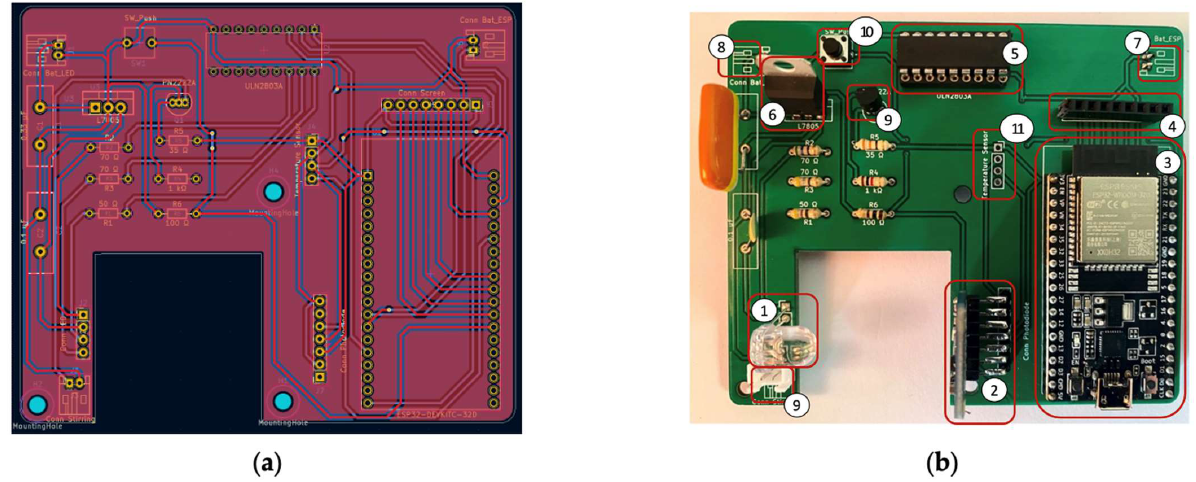
Figure 6. ( a ) Schematic view of developed PCB; ( b ) front view of physical PCB with main electronic components